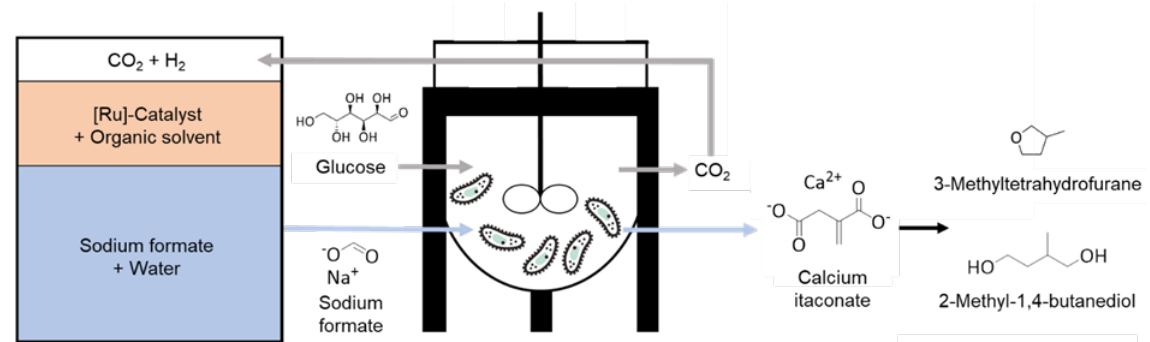
Figure 1. Schematic overview—implementation of CO 2 -derived formate from chemo-catalysis as co-substrate for itaconate production in biocatalysis. In a multiphasic approach with separable and recyclable metal catalyst, CO 2 is hydrogenated to the respective formate salt. The obtained aqueous product solution from chemo-catalysis is directly applied as a co-feed for the biocatalytic production of itaconate from glucose by Ustilaginaceae. Possible application of itaconic acid for the production, e.g., of biofuels such as 3-methyl-tetrahydrofuran (3 − MTHF) and 2 − methyl − 1,4 − butanediol, are depicted [27,28].